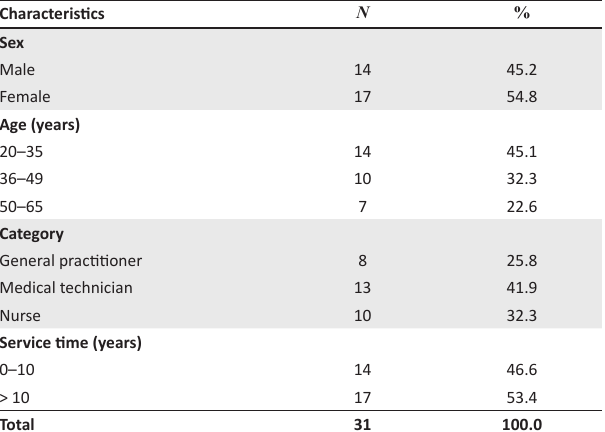
TABLE 1: Prescribers’ demographic characteristics.